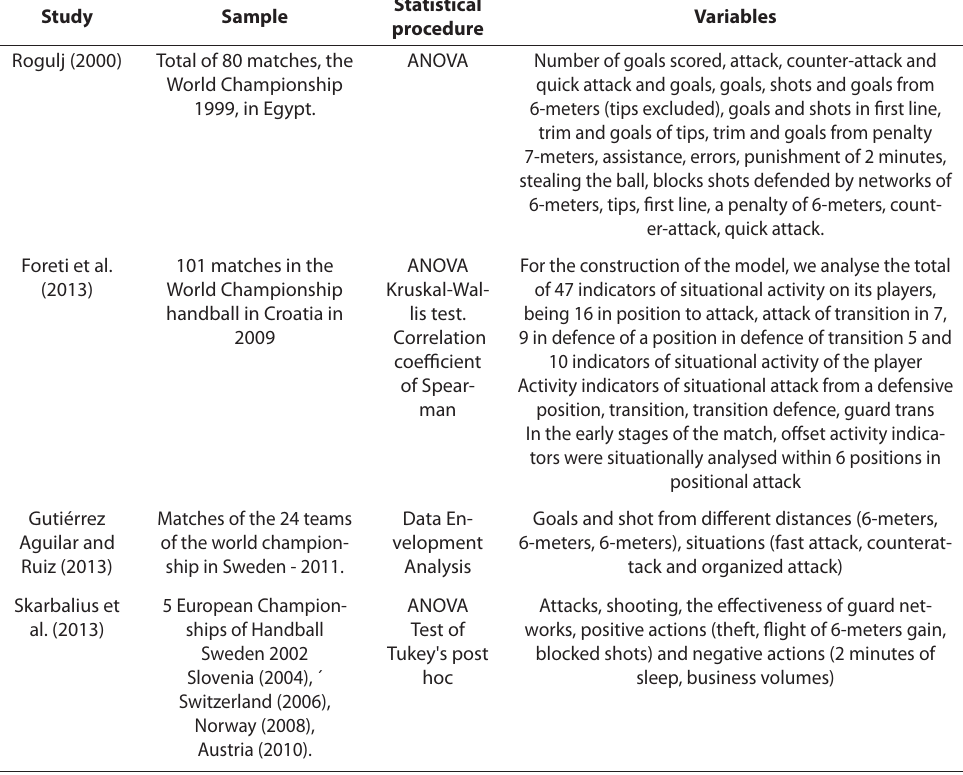
TABLE 4 Empirical studies with predominantly comparative analysis based on winners and losers Study